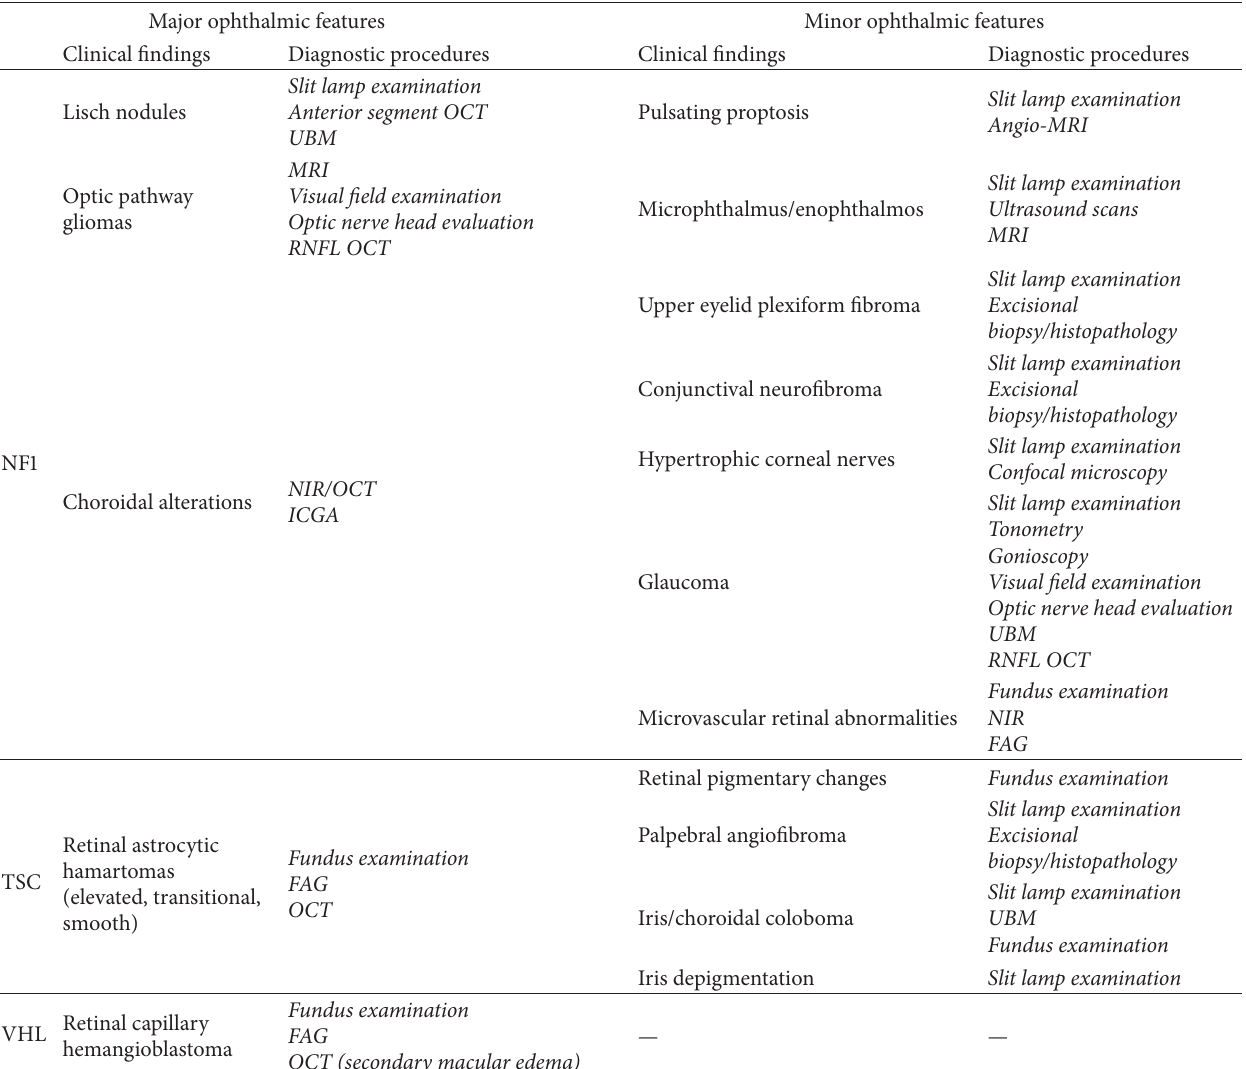
Table 1: Clinical findings and diagnostic procedures in the